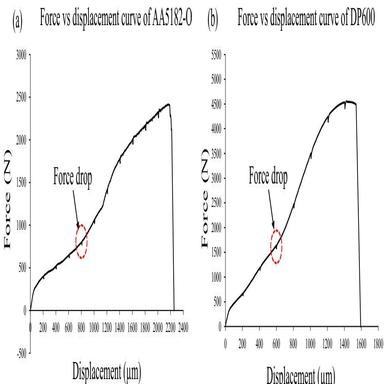
Force vs displacement curve of (a) AA5182-O and (b) DP600 when elongation was interrupted at every 0.2 mm of extension with the interrupted locations shown as drops in force.